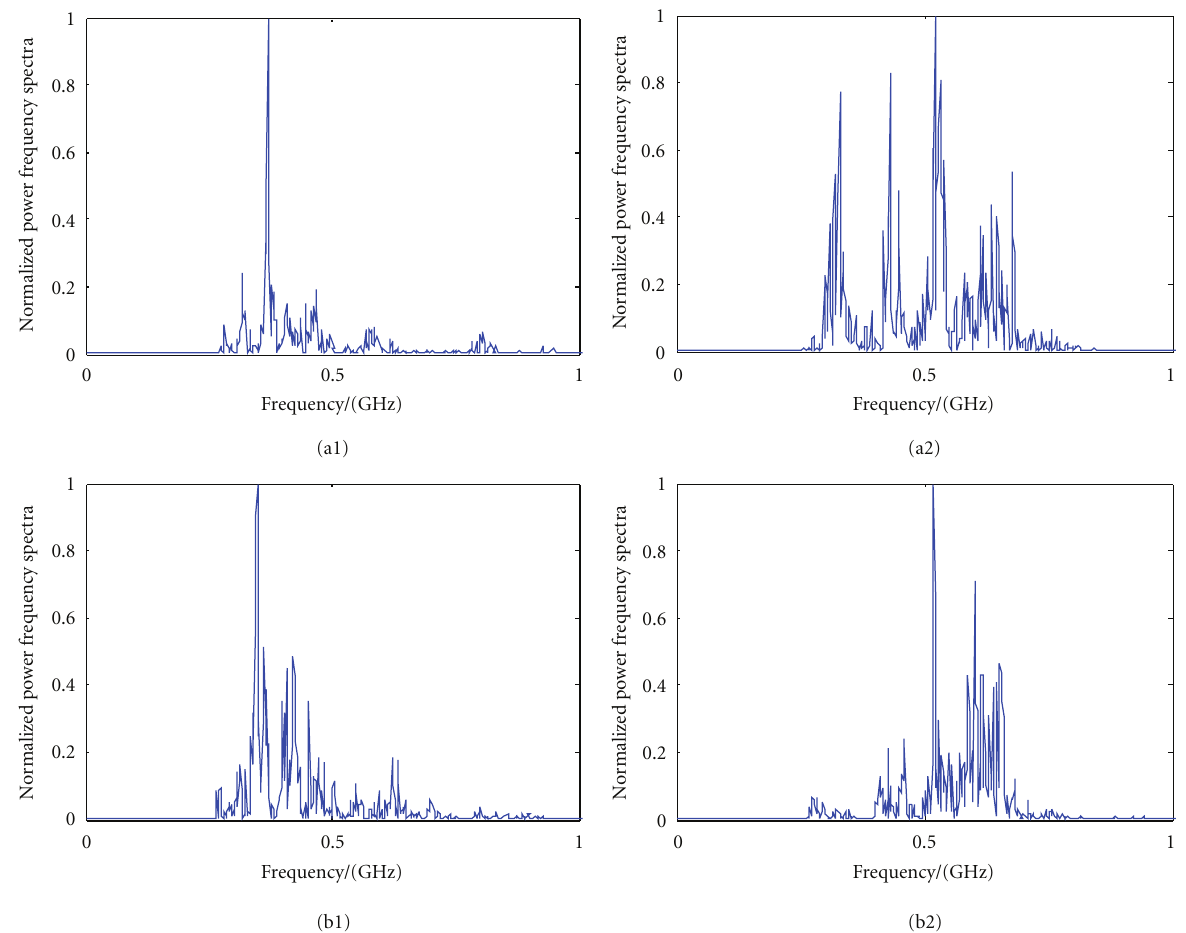
Figure 12: Normalized power frequency spectra of UHF PD signals from the two models: (a) signals from corona and surface models detected by Hilbert antenna; (b) signals from corona and surface models detected by Peano antenna.